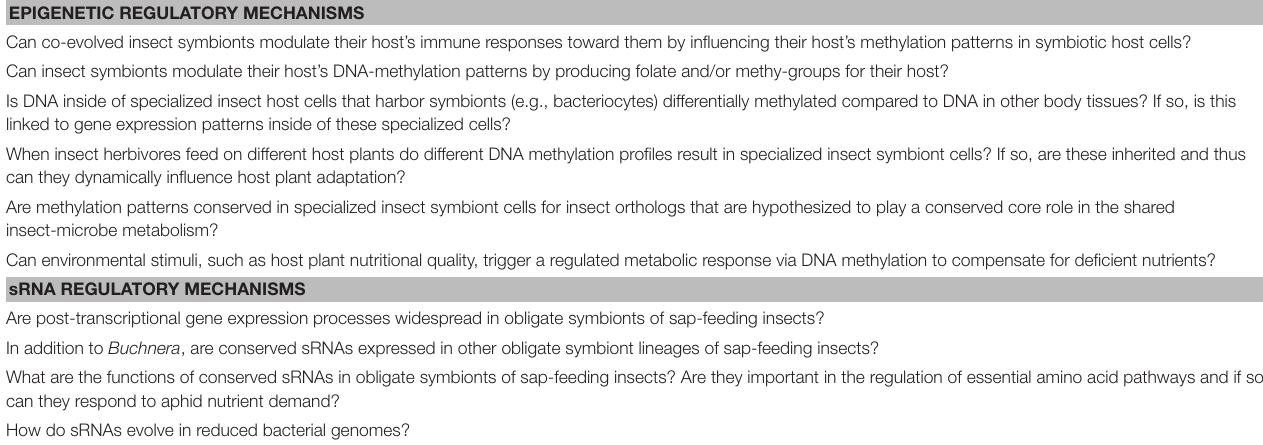
TABLE 4 | Outstanding questions in regard to the relative importance of regulatory mechanisms that are key to shared herbivore-microbe metabolisms. EPIGENETIC REGULATORY